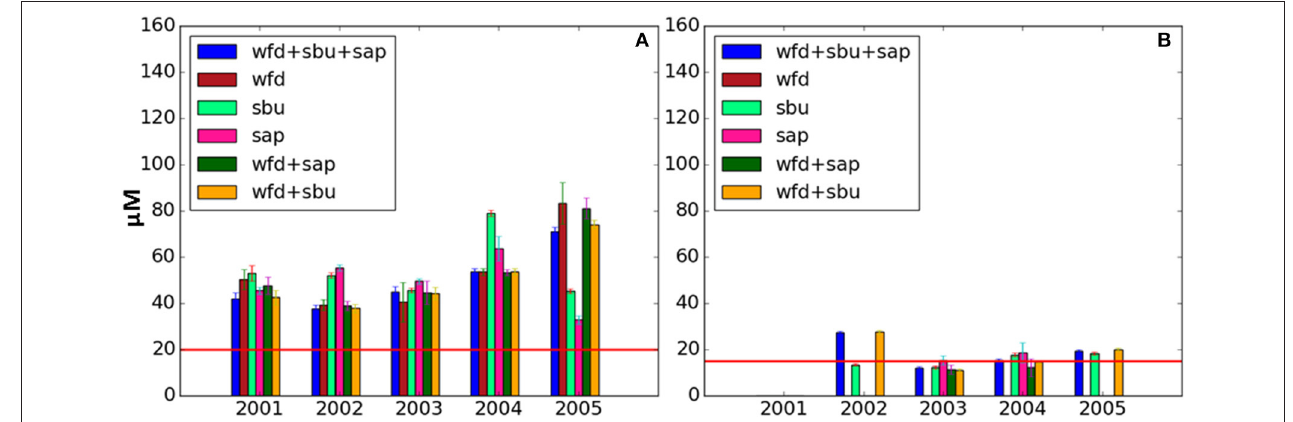
FIGURE 6 | Bar plot showing the results of the OSPAR COMP2 assessment for DIN in coastal waters (A) and offshore waters (B) together with the 95th confidence intervals. Each bar represents one of the analyzed data aggregations given in section Aggregation scenarios. The red line shows the assessment threshold.